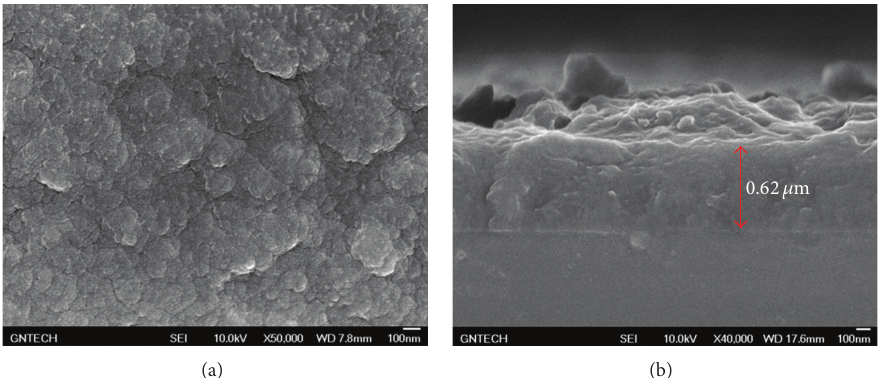
Figure 1: FE-SEM images of (a) surface and (b) cross-section images of LiNiO 2 thin film deposited on Si wafer substrate.